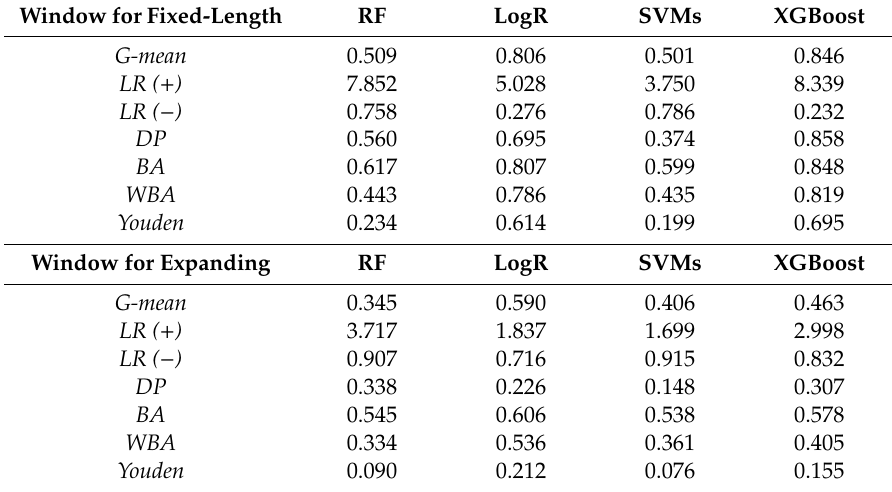
Table 4. Model validation measures of daily data for Dataset1.